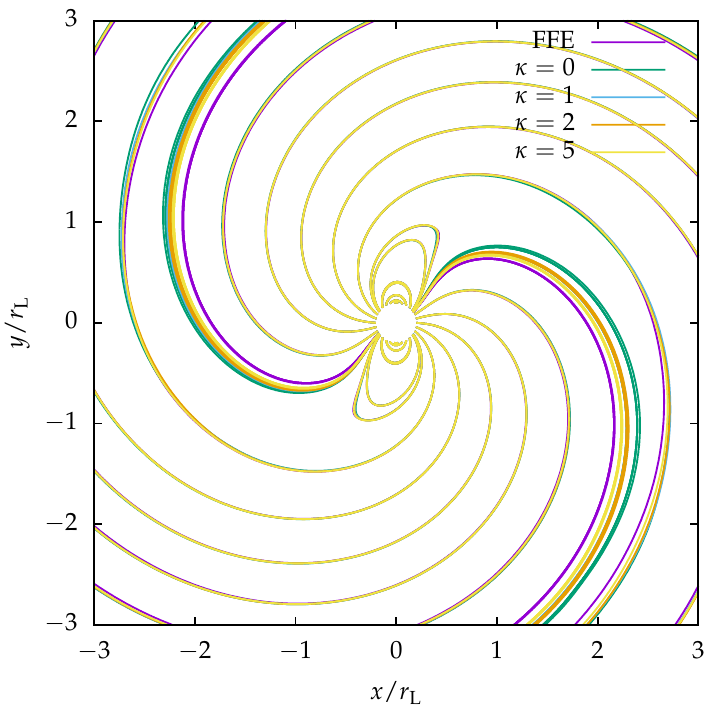
Figure 1. Magnetic field lines for orthogonal ( χ = 90 ◦ ) force-free (FFE) and radiative magnetospheres for different values of pair multiplicity κ